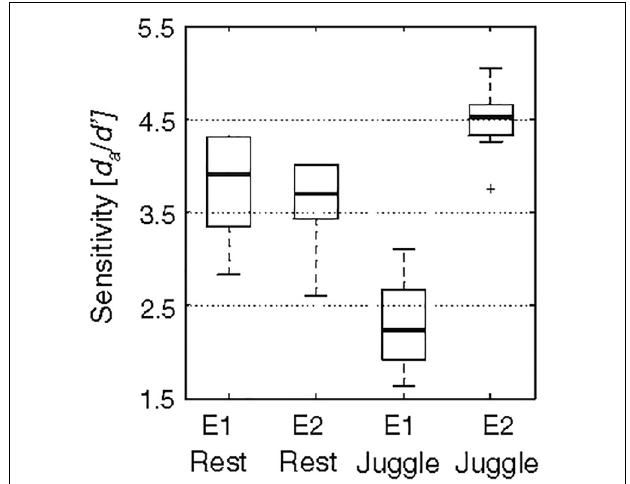
FIGURE 5 | Results from Juravle and Spence’s (2011) study highlighting that movement-induced sensory perception changes are specific to the type of sensory input and its relevance to the movement. E1 refers to Experiment 1 and shows that the sensitivity ( y -axis) in detecting a gap in tactile stimulation was lower when delivered to the hand that was juggling than when delivered to the hand at rest. E2 refers to Experiment 2 and shows that the sensitivity in detecting a gap in auditory stimuli was higher when delivered during the juggling condition. Box plots represent the middle 50% of data (dark line = median) and whiskers represent the interquartile range (+sign = values 1.5 times the inter-quartiles range). [From Figure 1a of Juravle and Spence (2011). Reproduced with permission of Springer Nature under Copyright Transfer Agreement and License to Publish Agreement of the author which allows adaption of figures for style and formatting purposes under the condition that this does not alter the meaning of the